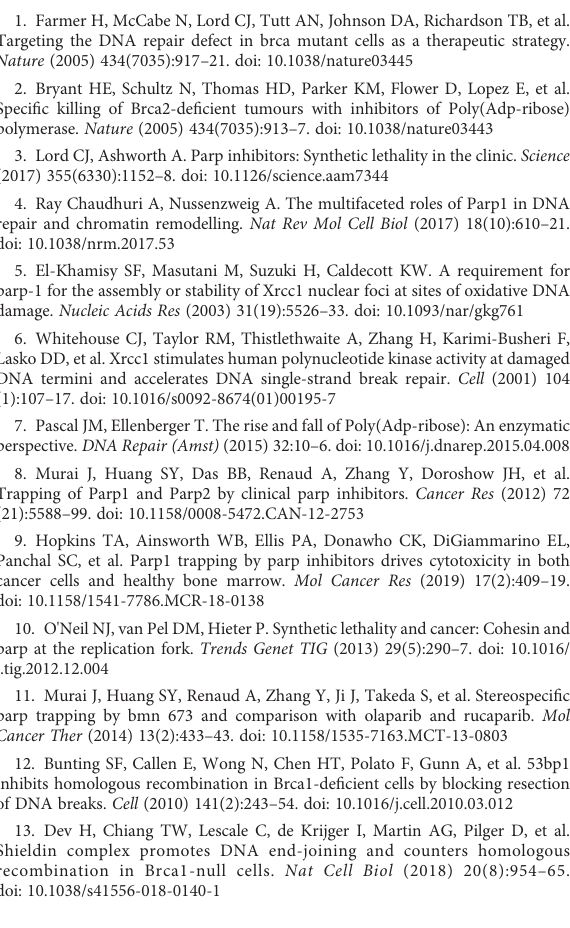
SUPPLEMENTARY FIGURE 1 (A) Sanger sequencing results of two mutations in BRCA2 gene.